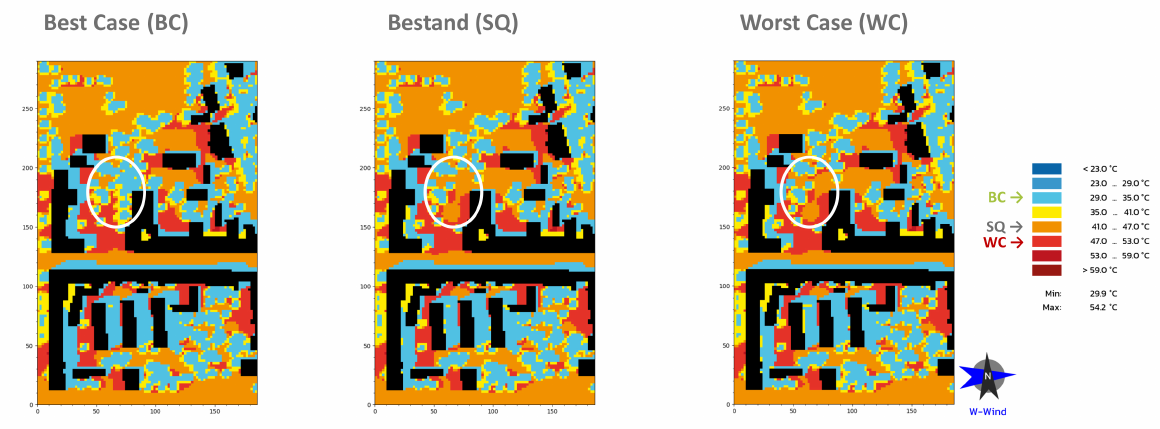
Figure 3. Physiological equivalent temperature (PET) 3 pm – Comparison between best case (BC), the state of the art (SQ) and the worst case (WC) scenarios. Simulation processing by grünplan.